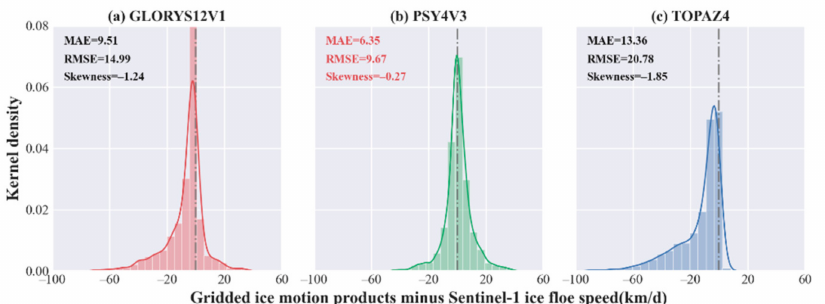
Figure 7. Kernel density of the deviation in the sea ice motion products ( a ) GLORYS12V1, ( b ) PSY4V3, and ( c ) TOPAZ4 from the ice floe speed extracted from